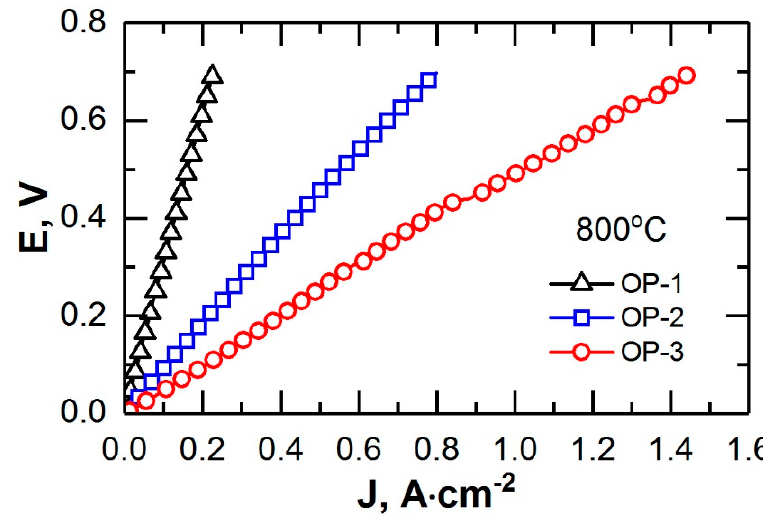
Figure 7. Current–voltage performances of the planar oxygen pumps at 800 ° С .